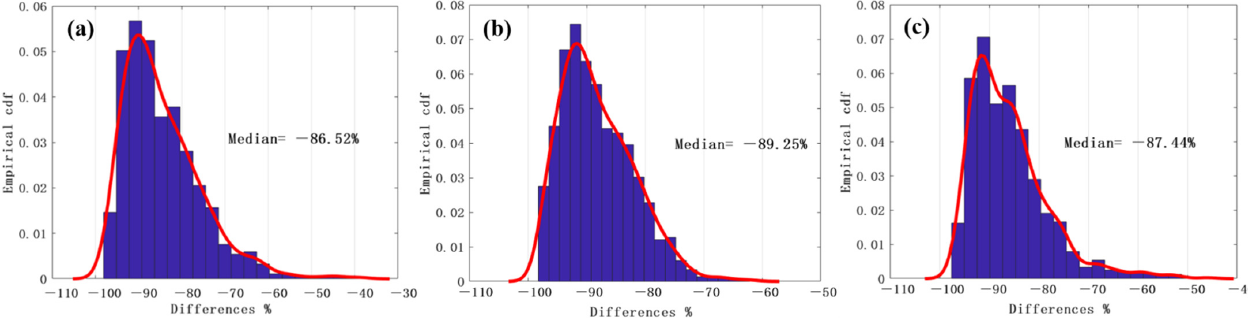
Figure 7. Relative change of CSES Ne corresponding to ionosonde Ne. Panels ( a – c ) are for Leshan, Tengchong and Puer, respectively. In each panel, the Y axis represents empirical cumulative distribution function (cdf).